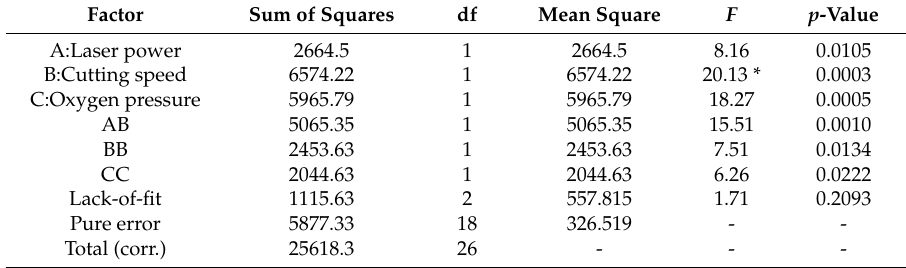
Table 7. ANOVA table for HAZ width. Asterisk (*) points out the factor with the strongest influence on HAZ